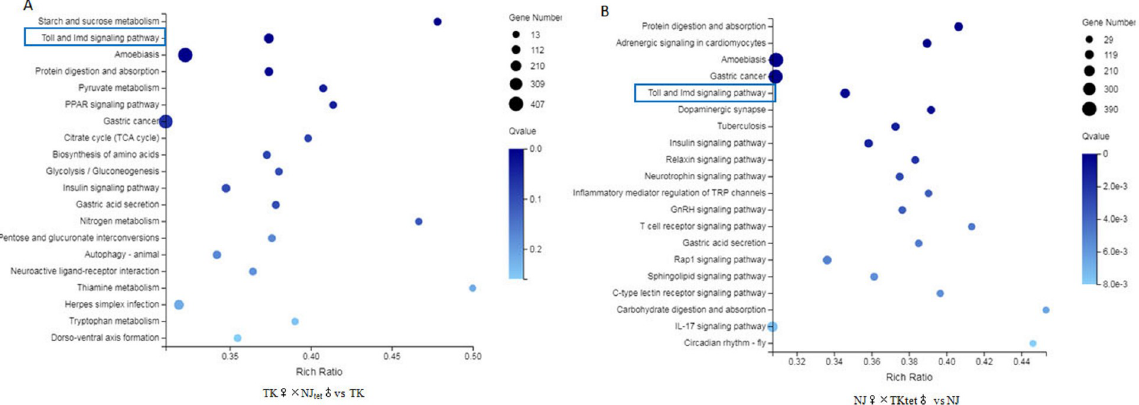
Fig 3. Up-regulation of Toll and IMD pathway genes in new host- Wolbachia symbioses. Pathway functional enrichment of DEGs. X axis represents enrichment factor. Y axis represents pathway name. The color indicates q value (high: white, low: blue), a lower q value indicates a more significant enrichment. Point size indicates DEG number (A bigger dot refers to a larger amount). Rich Factor refers to the value of enrichment factor, which is the quotient of foreground value (the number of DEGs) and background value (total Gene amount). A larger Rich Factor value indicates a higher level of